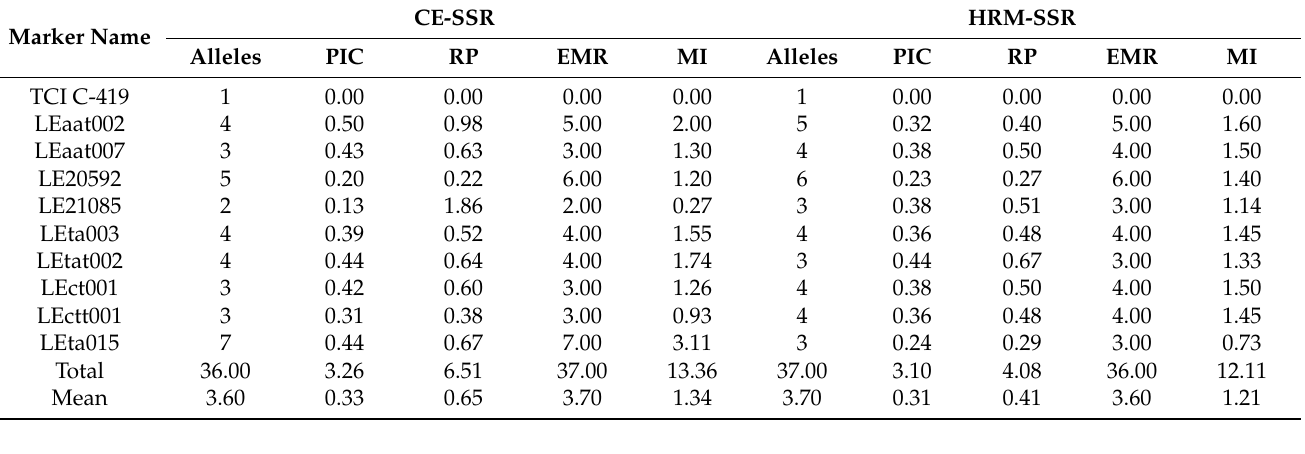
Table 4. Number of loci, polymorphic index content value (PIC), resolving power (RP), effective multiple ratio (EMR) and marker index (MI) obtained by the SSRs used in the present work using capillary electrophoresis (CE) and high resolution melting HRM) analysis.